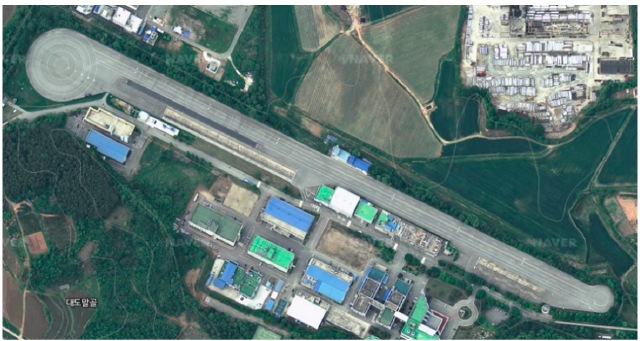
Figure 14. Testing ground at the Korea Automotive Technology Institute. Table 2. Dataset statistics.